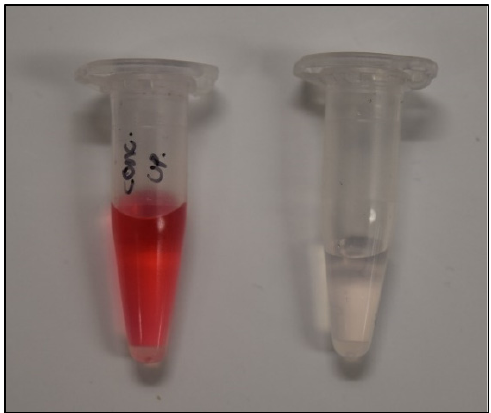
Figure 9. A measure of 50 µM direct red 80 feed solution ( left ) versus 50 µM direct red 80 permeate solution ( right ) that has been run through an azo-functionalized polycarbonate filter, resulting in (96.4 ± 1.4%) rejection.